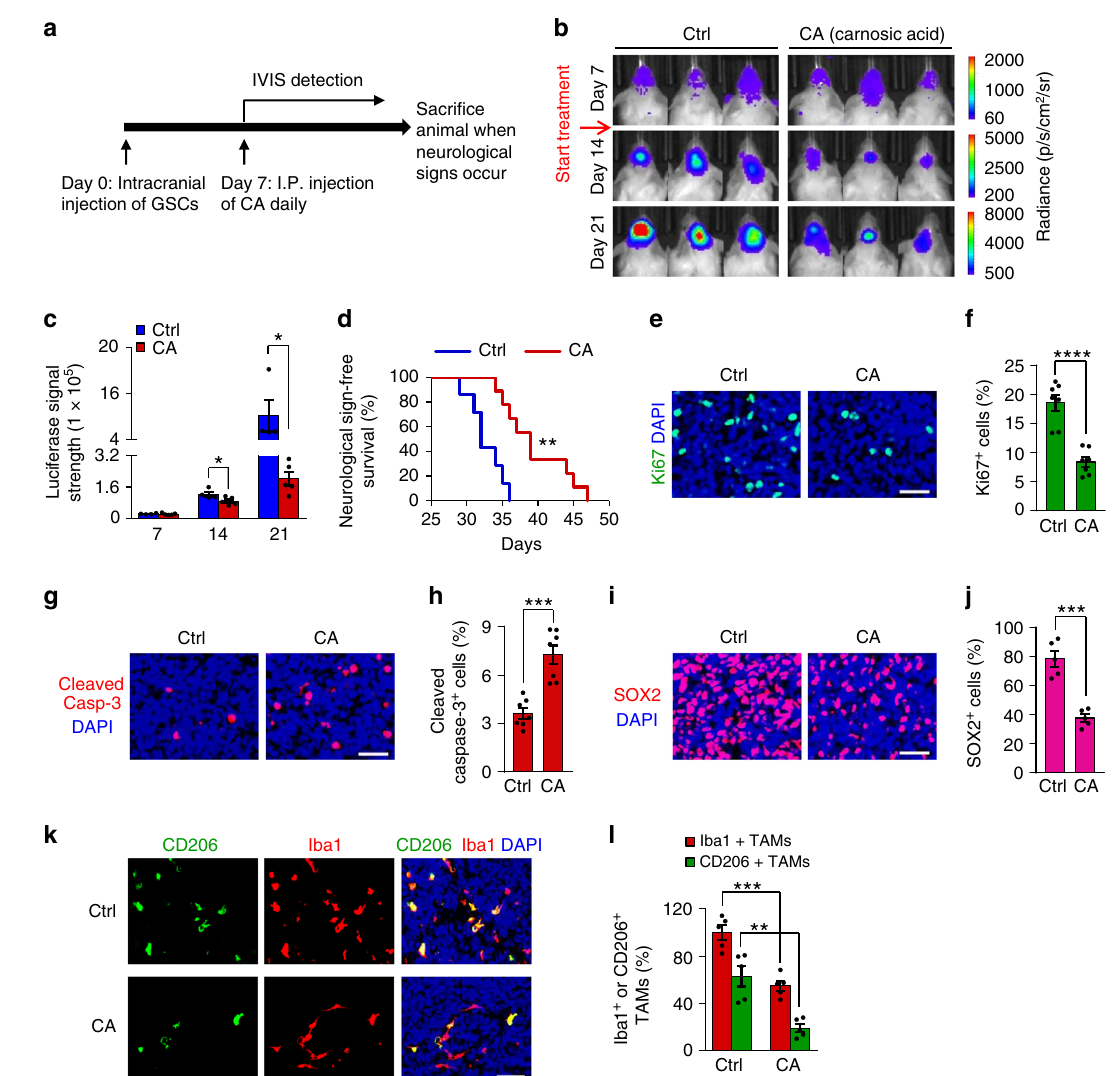
Fig. 8 CA treatment reduced GSCs and M2 TAMs and inhibited GBM tumor growth. a A schematic diagram showing the CA treatment of mice bearing the GBM xenografts derived from luciferase-expressing GSCs. b , c In vivo bioluminescent images ( b ) and quanti fi cation ( c ) of the T4121 GSC-derived xenografts after treatment with CA or the vehicle control at the indicated days after implantation. n = 4 (Ctrl) or 5 (CA) mice. Data are represented as mean ± s.e.m. * p = 0.0482 (day 14), * p = 0.039 (day 21), two-tailed unpaired t -test. p, photons; sr, steradian. d Kaplan – Meier survival curves of mice bearing T4121 GSC-derived xenografts treated with CA or the vehicle control. n = 7 (Ctrl) or 9 (CA) mice. CA-treated group vs. control group: ** p = 0.0011, log-rank test. e , f , Immuno fl uorescent staining of Ki67 (green, e ) and quanti fi cation of Ki67 + cells ( f ) in T4121 GSC-derived tumors after treatment with CA or the vehicle control. n = 7 biological independent tumor tissues. Scale bar: 40 μ m. Data are shown as mean ± s.e.m. **** p <0.0001, two-tailed unpaired t -test. g , h Immuno fl uorescent staining of Cleaved Caspase-3 (red, g ) and quanti fi cation of Cleaved Caspase-3 + cells ( h ) in T4121 GSC-derived tumors after treatment with CA or the vehicle control. n = 7 biological independent tumor tissues. Scale bar: 40 μ m. Data are represented as means ± s.e. m. *** p = 0.0002, two-tailed unpaired t -test. i , j Immuno fl uorescent staining of SOX2 (red, i ) and quanti fi cation of SOX2 + cells ( j ) in T4121 GSC-derived tumors after treatment with CA or the vehicle control. n = 5 biological independent tumor tissues. Scale bar: 40 μ m. Data are represented as means ± s.e. m. *** p = 0.0002, two-tailed unpaired t -test. k Immuno fl uorescence staining of the M2 TAM Marker CD206 (green) and the pan-macrophage marker Iba1 (red) in T4121 GSC-derived tumors after treatment with CA or the vehicle control. Scale Bar, 50 μ M. l Quantitation of CD206 + TAM density and Iba1 + total TAM density in xenografts treated with CA or the vehicle control. n = 5 biological independent tumor tissues. Data are shown as means ± s.e.m. ** p = 0.0017, *** p = 0.0003; two-tailed unpaired t -test. Source data are provided as a Source data fi